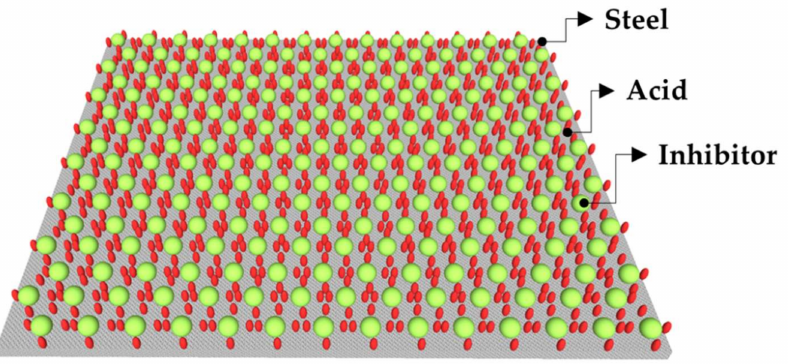
Figure 1. Adsorption action of inhibitor on steel